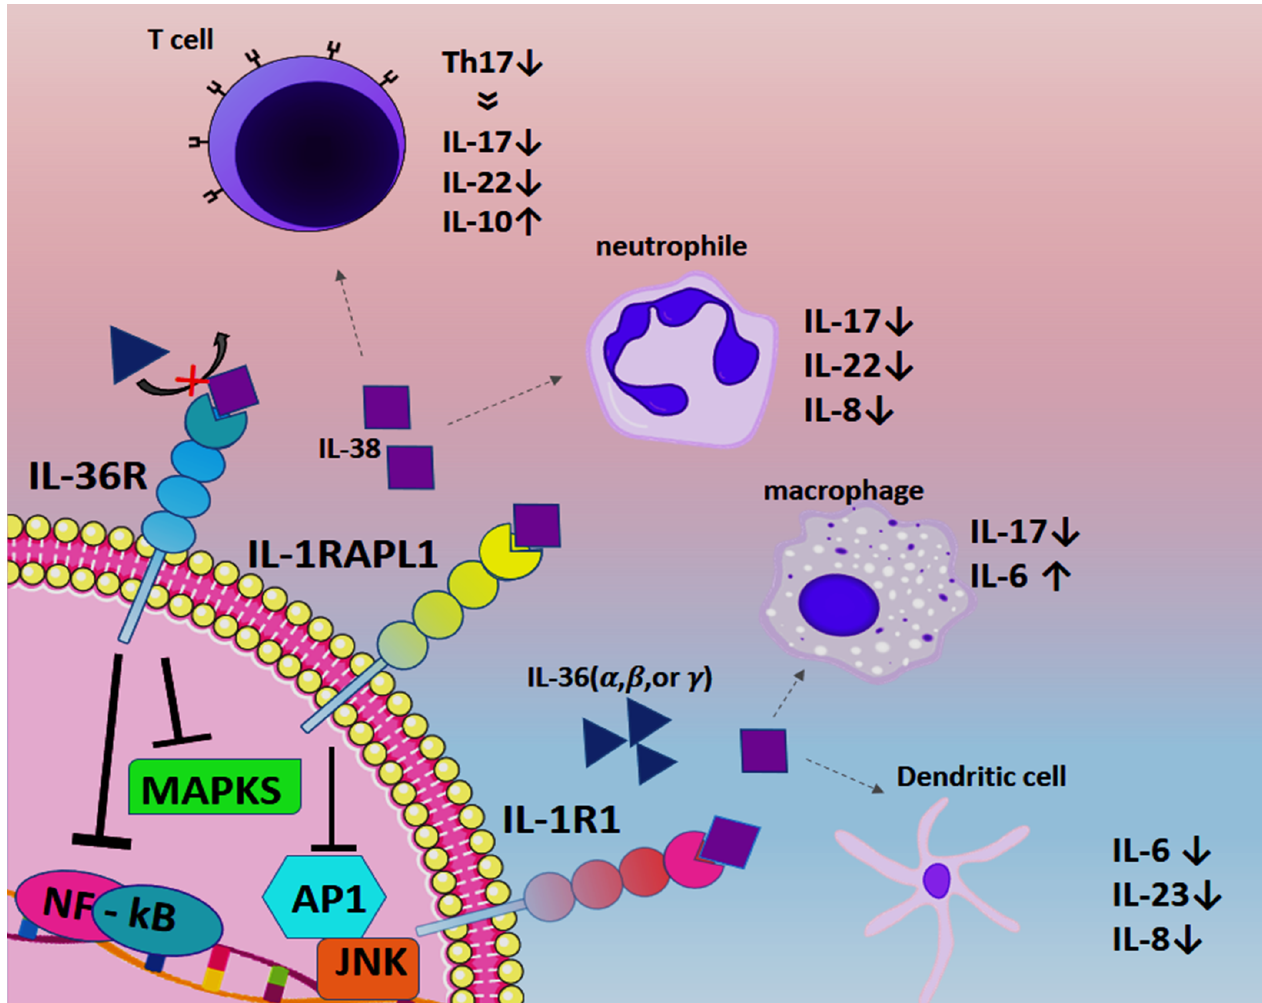
Figure 5. Interactions between IL-38 and involved immunological cells. Created by Esmaeilzadeh et al. Three important receptors of IL-38 and their immunomodulatory effects alter the secretion of pro-inflammatory and anti-inflammatory cytokines. Hence, IL-38 acts as a two-edged sword in immune microenvironments.